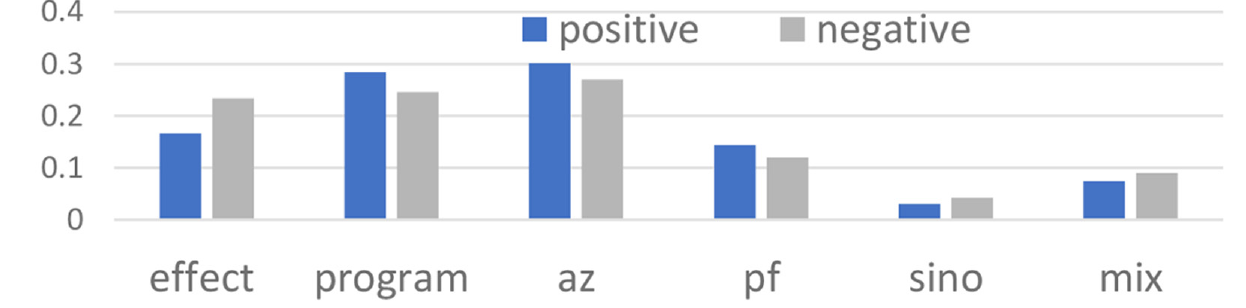
Figure 5. Topic sentiments’ probabilities.